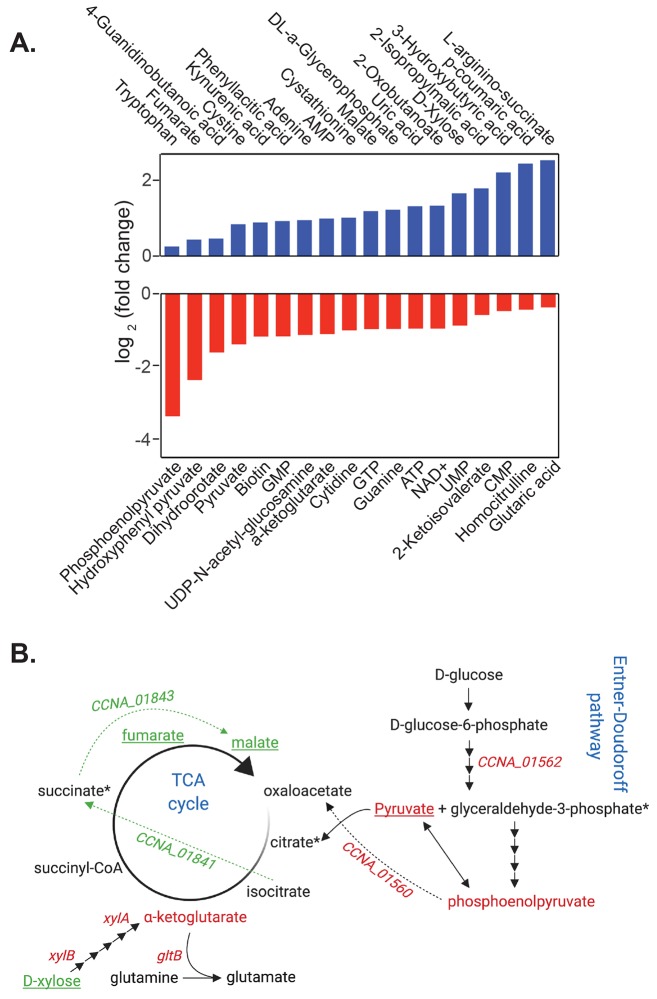
CdnL is required for metabolic homeostasis in Caulobacter.A. Graph showing significantly altered metabolites (P < 0.05) in ΔcdnL compared to WT grown in PYE from S5 Table. B. Summary figure depicting changes in glucose metabolism and TCA cycle in ΔcdnL cells as compared to WT. Genes and metabolites shown in red are downregulated and in green are upregulated. Arrows in green indicate glyoxylate bypass pathway. Underlined metabolites are changed across all media types, whereas those in black are unchanged. Dashed arrows indicate pathways that are active only under some conditions. * indicates metabolites not detected. n = 3 for each strain in each condition.